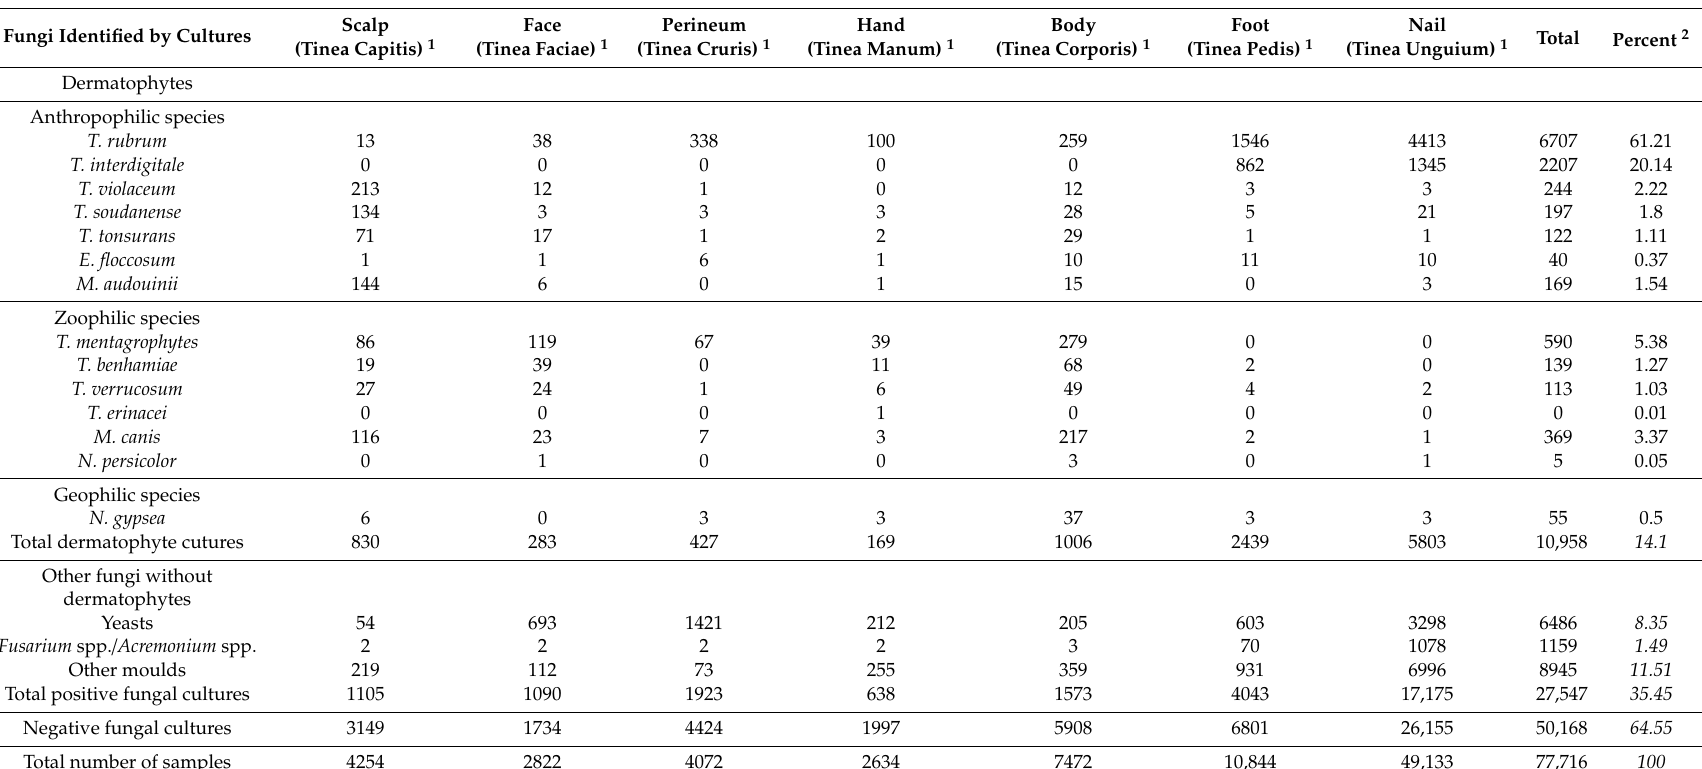
Table 1. Prevalence of di ff erent fungi in dermatological samples analyzed in this